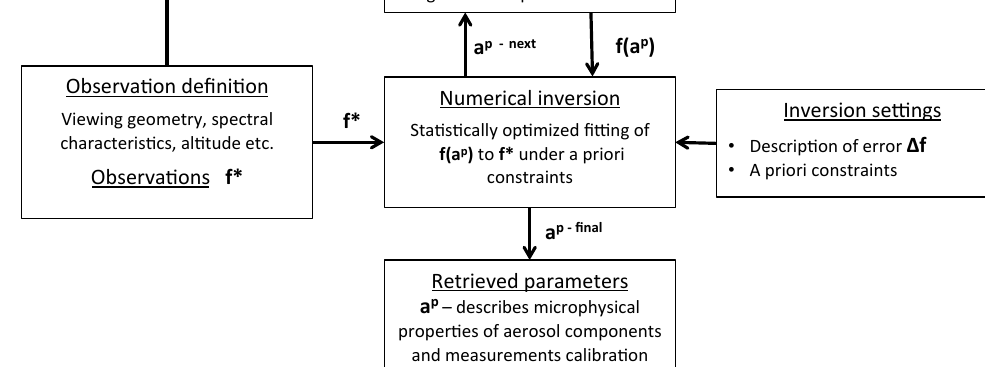
Fig. 2. General structure of the inversion algorithm.